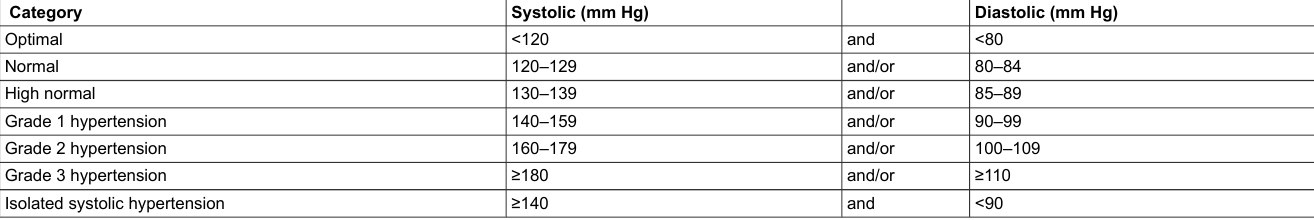
Table 2: Classification of office blood pressure * and definition of hypertension grade ** (modified from: Williams B, et al. 2018 ESC/ESH Guidelines for the management of arterial hyper- tension. J Hypertens. 2018;36(10):1953–2041 [36]). Category Optimal